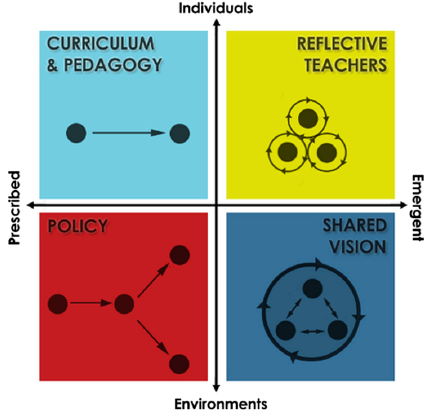
FIG. 3. Four types of change strategies. Adapted from Henderson, Beach, and Finkelstein [22]; image credit to Alexis